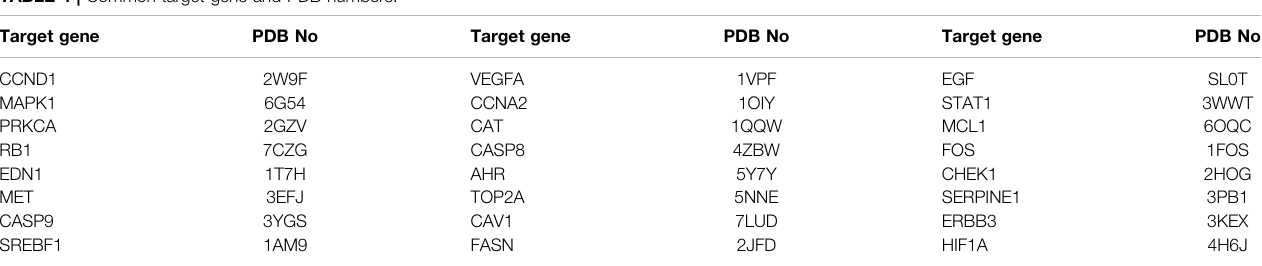
TABLE 4 | Common target gene and PDB numbers.